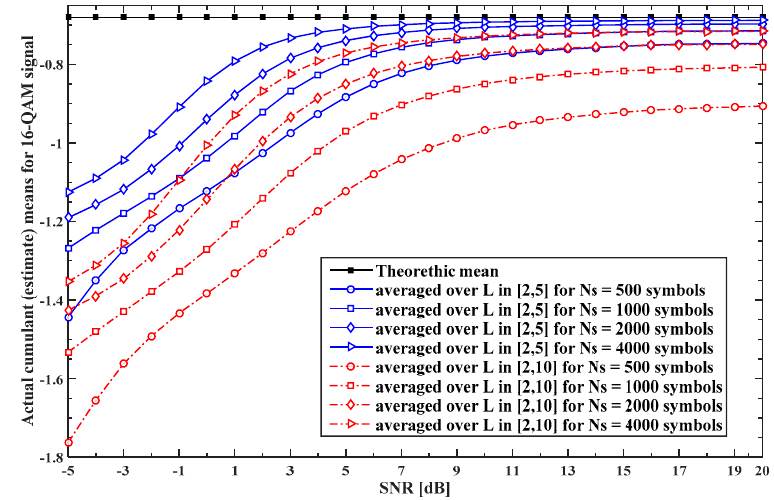
Figure 2. The actual cumulant (estimate) means for the 16QAM signal averaged over 𝐿 ∈ {2,⋯ , 5} and 𝐿 ∈ {2,⋯ , 10} as a function of signal-to-noise ratio (SNR) for the MC with the blind channel estimation method (BCEM).